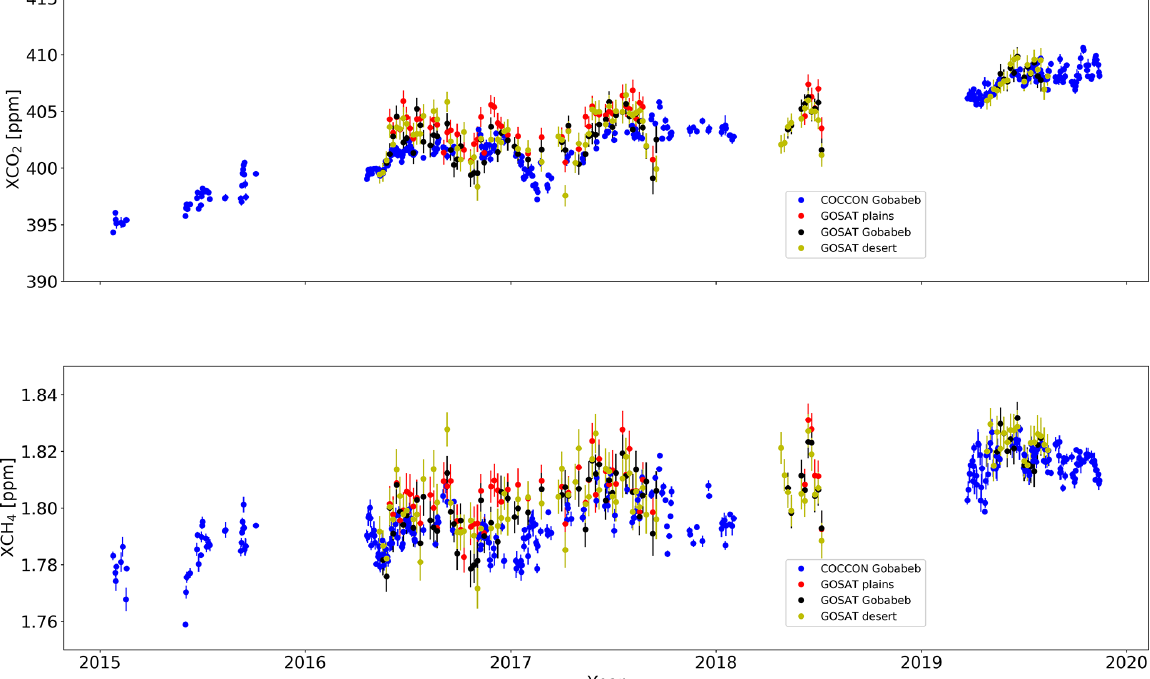
Figure 9. Column-averaged dry-air mole fraction daily mean time series for XCO 2 and XCH 4 measured at the COCCON site in Gobabeb (blue dots) and GOSAT observations from the three specific target observation points with different surface albedos close to Gobabeb are shown (red dots: gravel plains, black dots: COCCON site, golden dots: sand desert). Error bars denote the 1 σ standard deviation of the daily mean values for COCCON measurements and the measurement error for the GOSAT